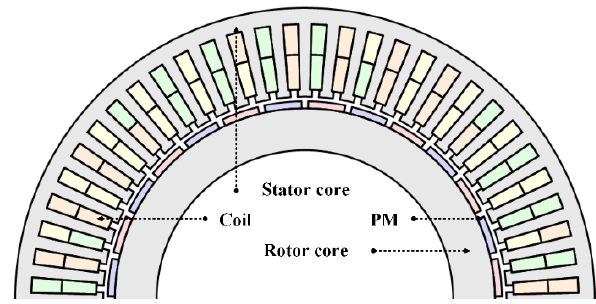
Figure 3. Two-dimensional FE analysis model.